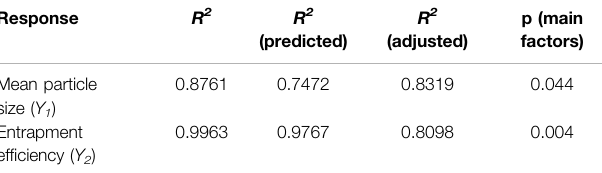
TABLE 5 | Summary of results of regression analysis for responses. Response